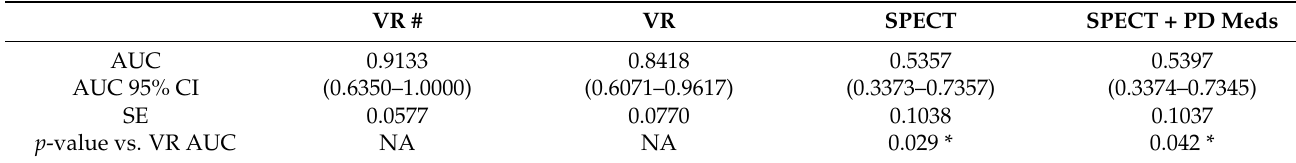
Table 3. Receiver operating characteristic (ROC) AUCs for detection of clinically important difference (CID) in motor dysfunction with VR, [ 123 I]FP-CIT SPECT, and SPECT + PD Meds using SVM.